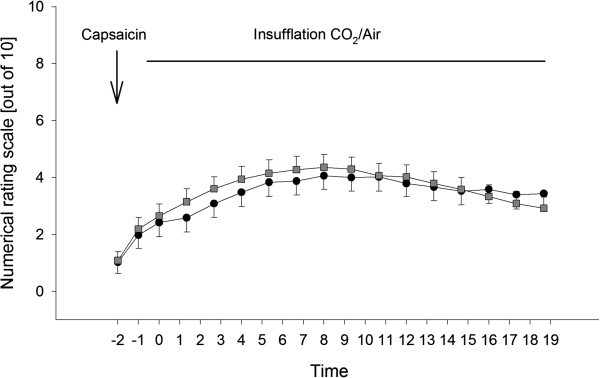
Continuous insufflation of either CO2 or air after administration of capsaicin. Pain ratings on a numerical rating scale from 0 to 10 before and during nasal insufflation of CO2 (black dots) with a flow of 1 l/min or compressed air (grey boxes) for 19 minutes after intranasal application of capsaicin. The time is given in minutes. Error bars are given as standard error of the mean.